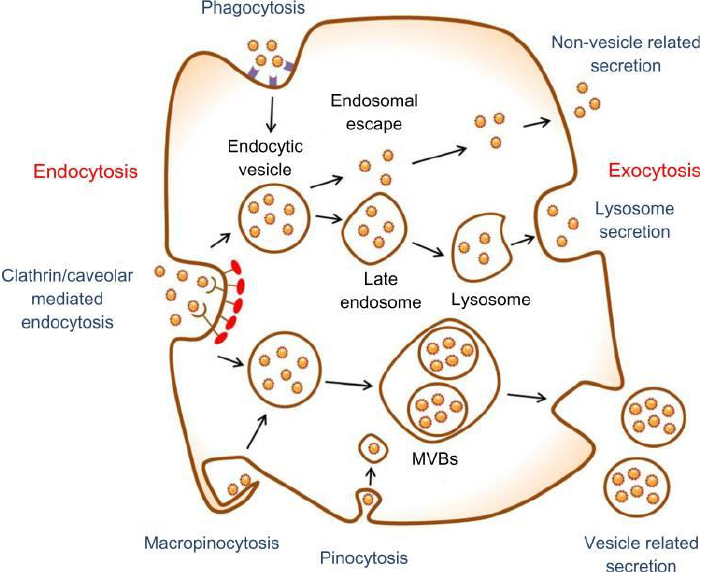
Figure 2. Schematic diagram describes the main pathways of NP uptake (endocytosis) and release (exocytosis) (Reproduced from [100] with permission from American Chemical Society).